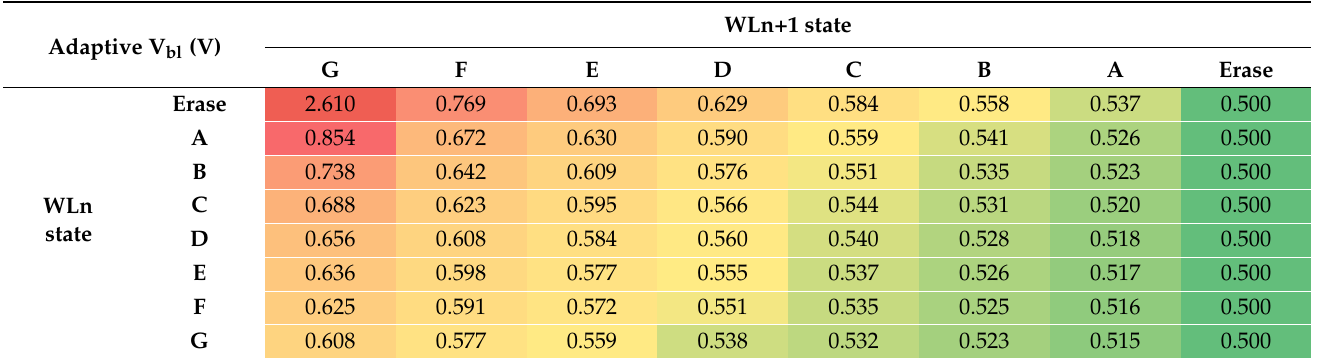
Figure 8. The NWI curves of WLn interfered by WLn+1 ( a ) G, ( b ) F, ( c ) E, ( d ) D, ( e ) C, ( f ) B, ( g ) A, and ( h ) Erase states. The red curve represents original NWI. The blue curve is the NWI result only with adaptive V bl in terms of pre ‐ reading WLn+1 states. The green curve is the NWI result with degressive adaptive V bl according to the pre ‐ reading of WLn+1 states and the read sequence of WLn states. Table 2. The degressive adaptive V bl values measured by TCAD simulations.